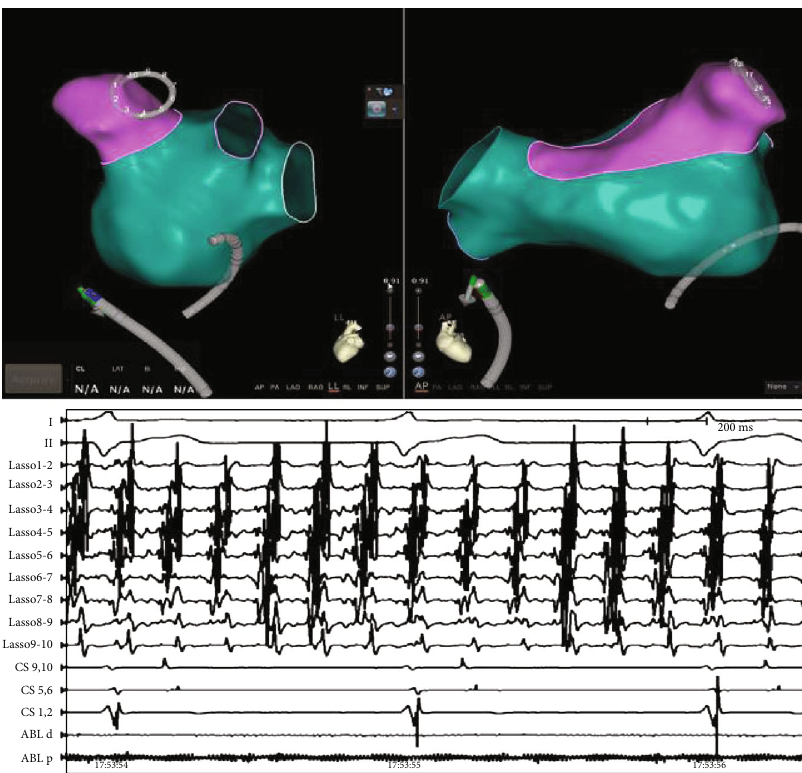
Figure 3: Activation mapping and intracardiac electrograms showing the LAA and surrounding area in AF (pink on activation map, lasso in the LAA) while the rest of the atria (green on the activation map) was in sinus rhythm.